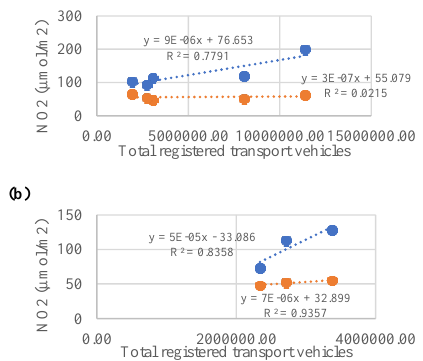
Figure 9. Influence of total registered transport vehicles on NO 2